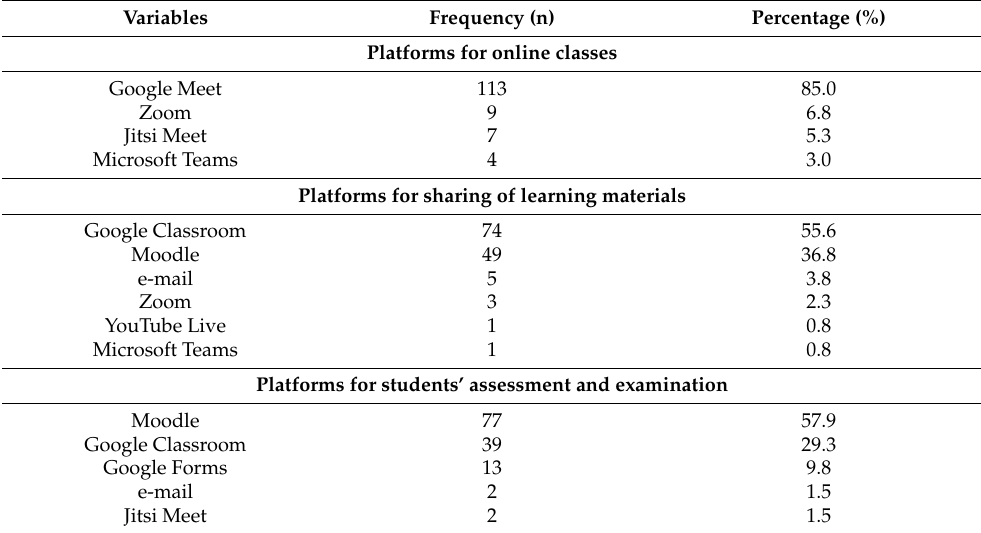
Table 7. Platforms for online classes, materials sharing and assessment.